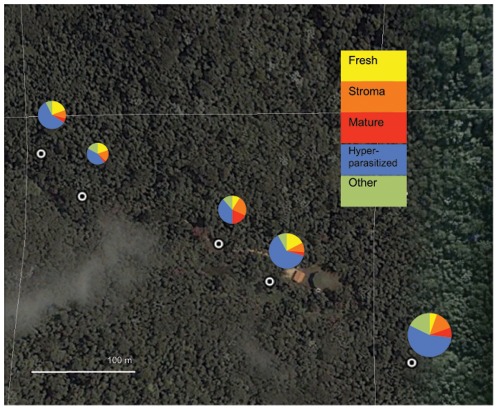
Graveyard location and cadaver distribution.Aerial photo (from GoogleEarth) of the sampling area in Mata do Paraíso with the five graveyards marked and the distribution of parasite life stages plotted as pie charts. A total of 432 dead infected ants were encountered, distributed with 41, 35, 44, 149 & 163 individuals, respectively, in graveyard 1–5.